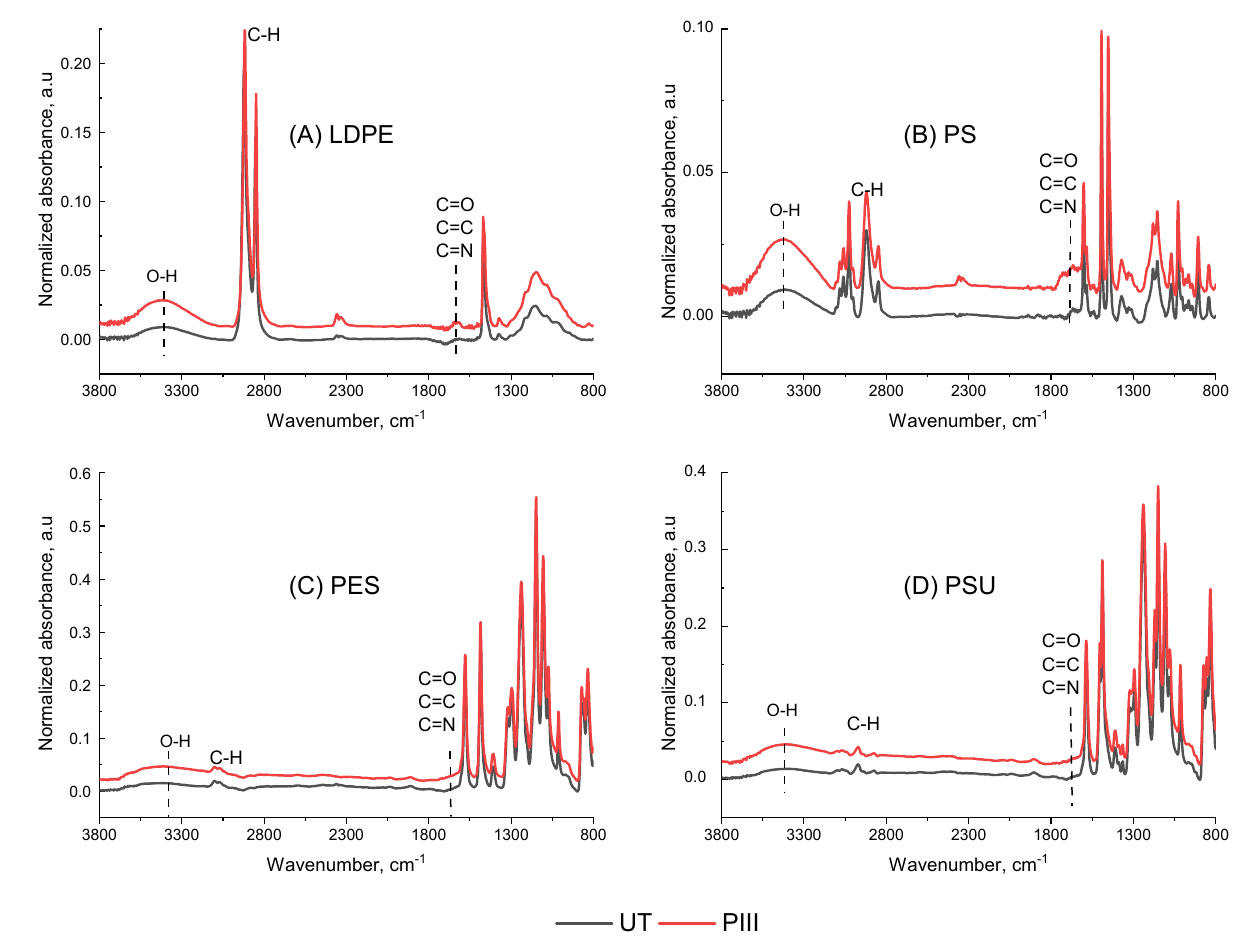
Figure 3. Comparison of FTIR-ATR spectra of the polymers before and after the PIII treatment. ( A ) LDPE, ( B ) PS, ( C ) PES and ( D ) PSU. Black and red lines represent spectra measured on untreated (UT) and PIII-treated polymers, respectively.